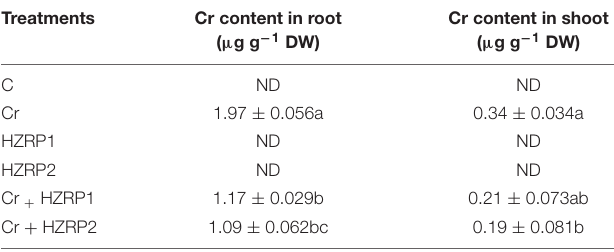
TABLE 2 | Effect of HZRP on Cr content in the root and shoot of V. radiata exposed to Cr stress.